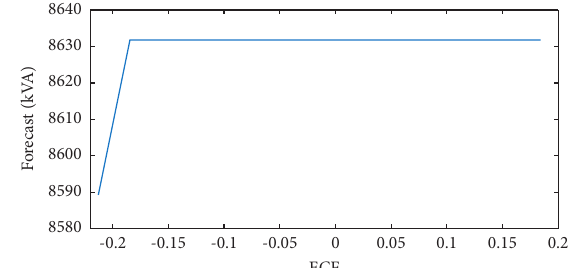
Figure 27: Correlation between forecast load and ECF for total system